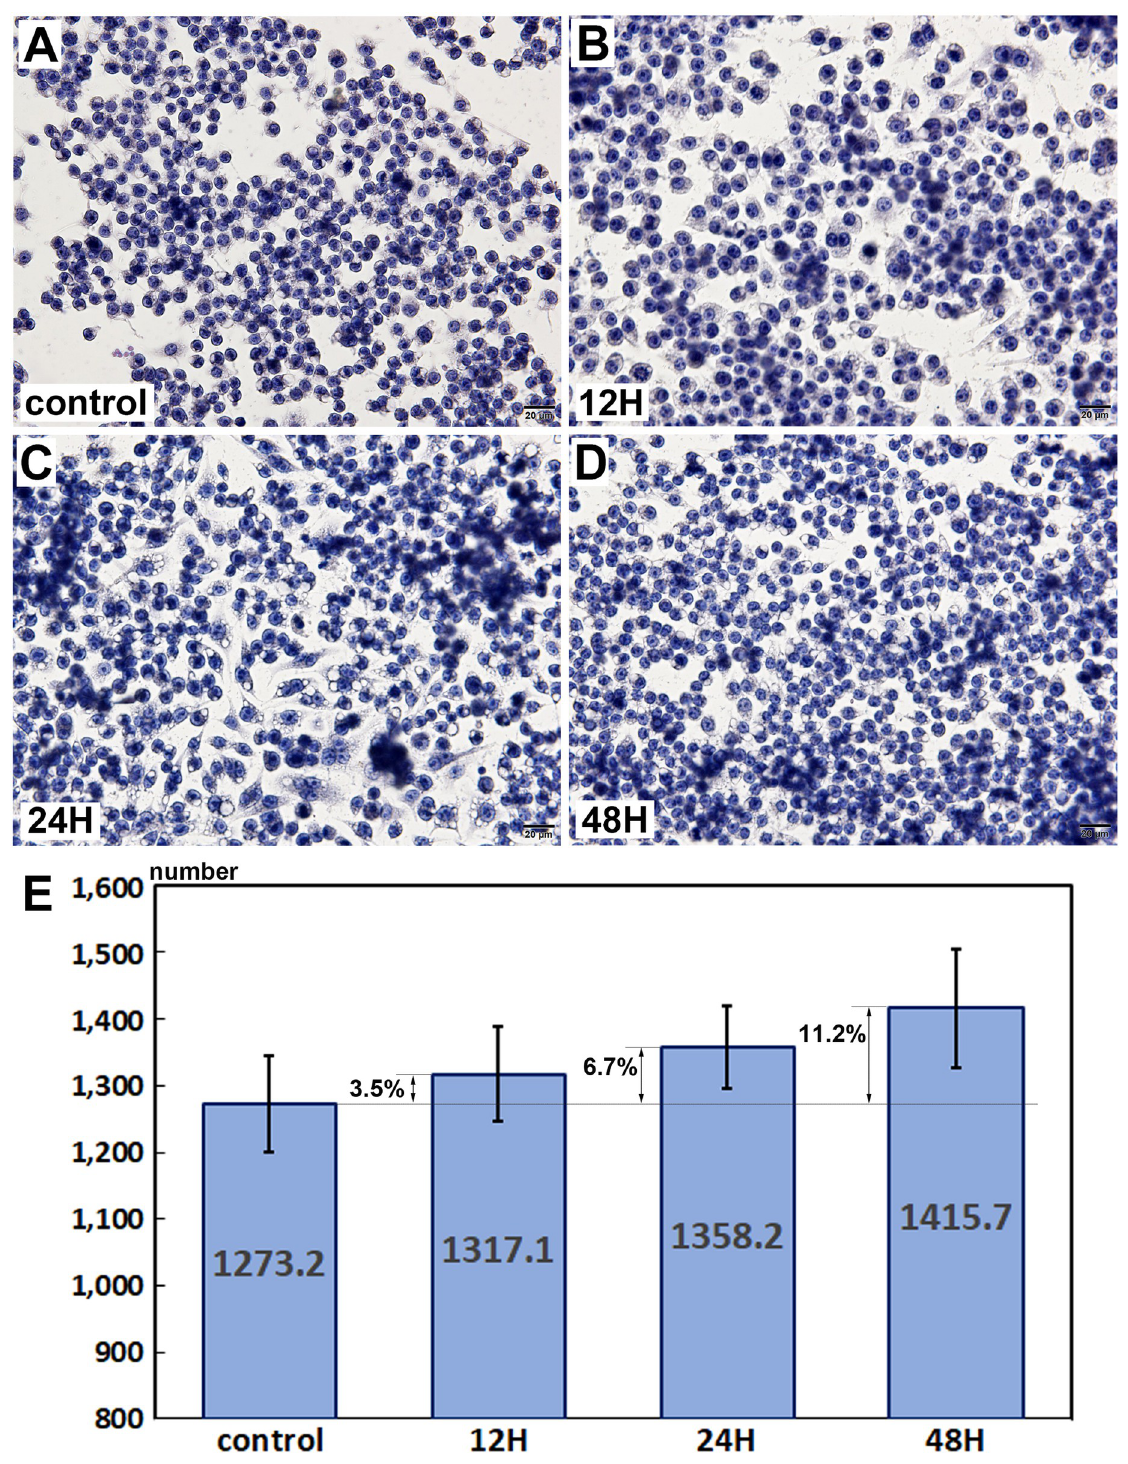
Fig 1. Proliferation of RAW 264.7 cells by direct cell counting with hematoxylin staining. 10 μ g/mL PTX-treated RAW 264.7 cells showed the increase of proliferation by 3.5% at 12 h, 6.7% at 24 h, and 11.2% at 48 h compared to the non-treated controls. A-D: Histological observation at x400 magnification, E: Statistical analysis plotted into a rod graph, cell number versus culture time (0, 12, 24, and 48 h).